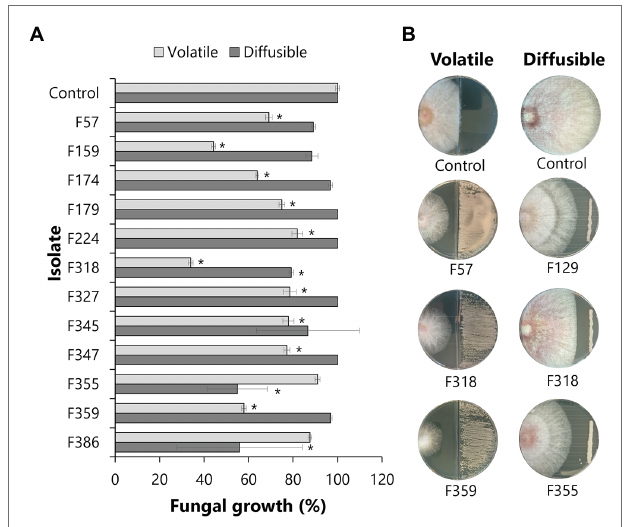
FIGURE 4 | Antagonistic activity of phyllosphere yeasts against F. graminearum . Each isolate was screened against F. graminearum for the production of volatile organic compounds (VOCs) or agar-diffusible compounds. (A) Bars represent the standard deviation of the mean growth percentage of 4 independent replicates. Statistical differences as compared to control (exposed to medium alone) were determined using Student’s t -test ( p < 0.05) and are indicated with an asterisk (*). (B) Pictures of the antagonistic activities by representative isolates made after 4 and 6 days of exposure for the volatile and agar-diffusible compounds,